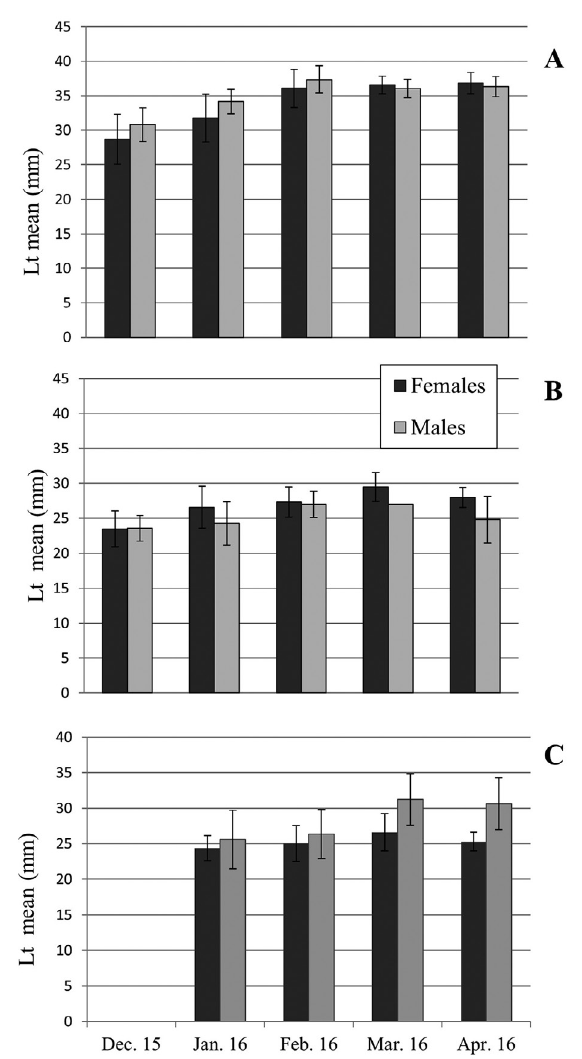
Fig. 3. – Mean total length (L in mm, by month and by sex, T throughout the fishing season 2015-2016) in sampled Aphia minuta (A), Pseudaphia ferreri (B) and Crystallogobius linearis (C). The bars represent the standard deviation.